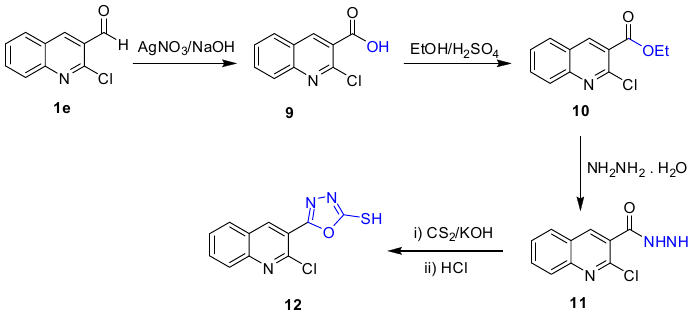
Table 1. % Parasite inhibition of Plasmodium falciparum by some quinolinyl derivatives 4 – 12 .